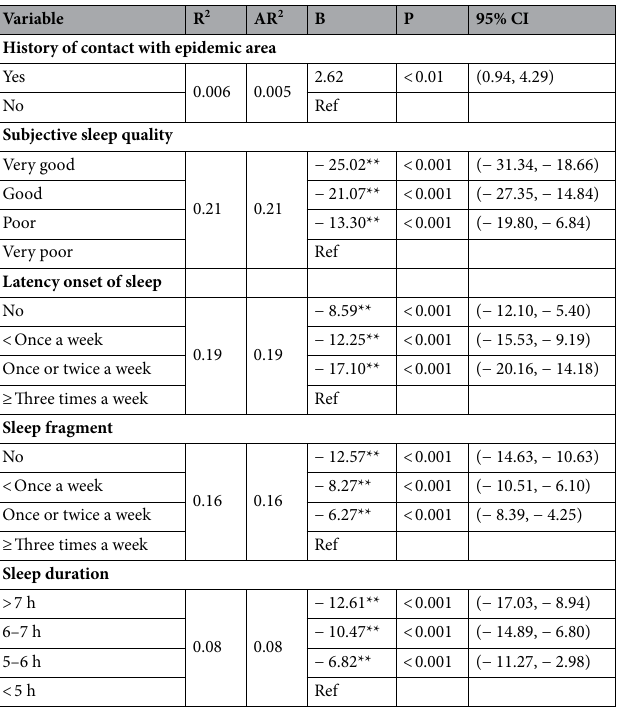
Table 3. Association between contact with epidemic area history, sleep quality and PTSS during outbreak of COVID-19 in China.